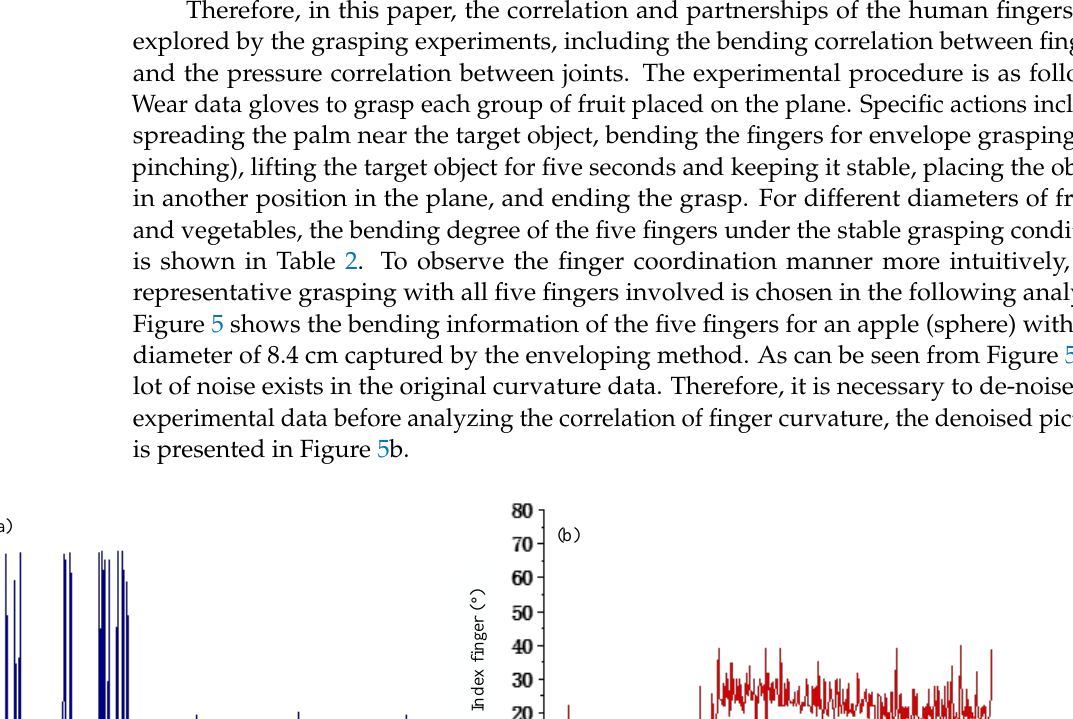
Table 2. Finger curvature under stable grasping of objects with different diameters.